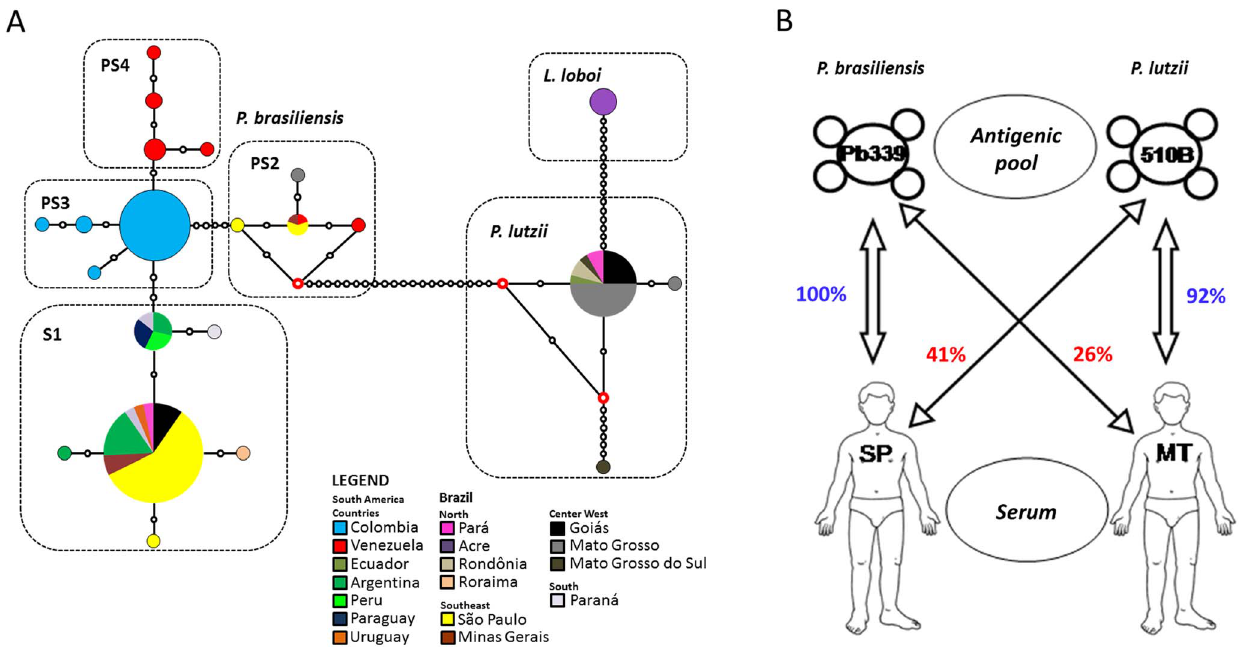
Figure 1. (A) Median-joining haplotypic network distribution of the Paracoccidioides genus and L. loboi based on the gp43 marker. The size of the circumference is proportional to the haplotype frequency, and colors vary according to the sampling location of each haplotype. Red dots (median vectors) are hypothetical missing intermediates, and black dots represent each mutation site. (B) Schematic representation of serum/antigen compatibility among patients and isolates from Mato Grosso and Sa˜o Paulo used in serological tests. The illustration shows the low immunogenic specificity when serum and antigenic pool from different states are reacted [41].